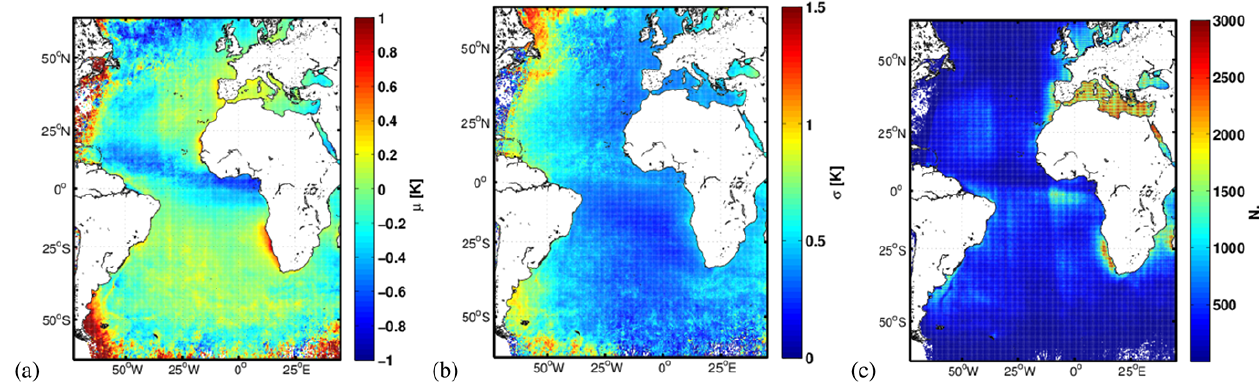
Figure 1. SEVIRI–AATSR (a) mean bias µ , (b) standard deviation σ , (c) number of match-ups N , binned in 25km × 25km boxes.